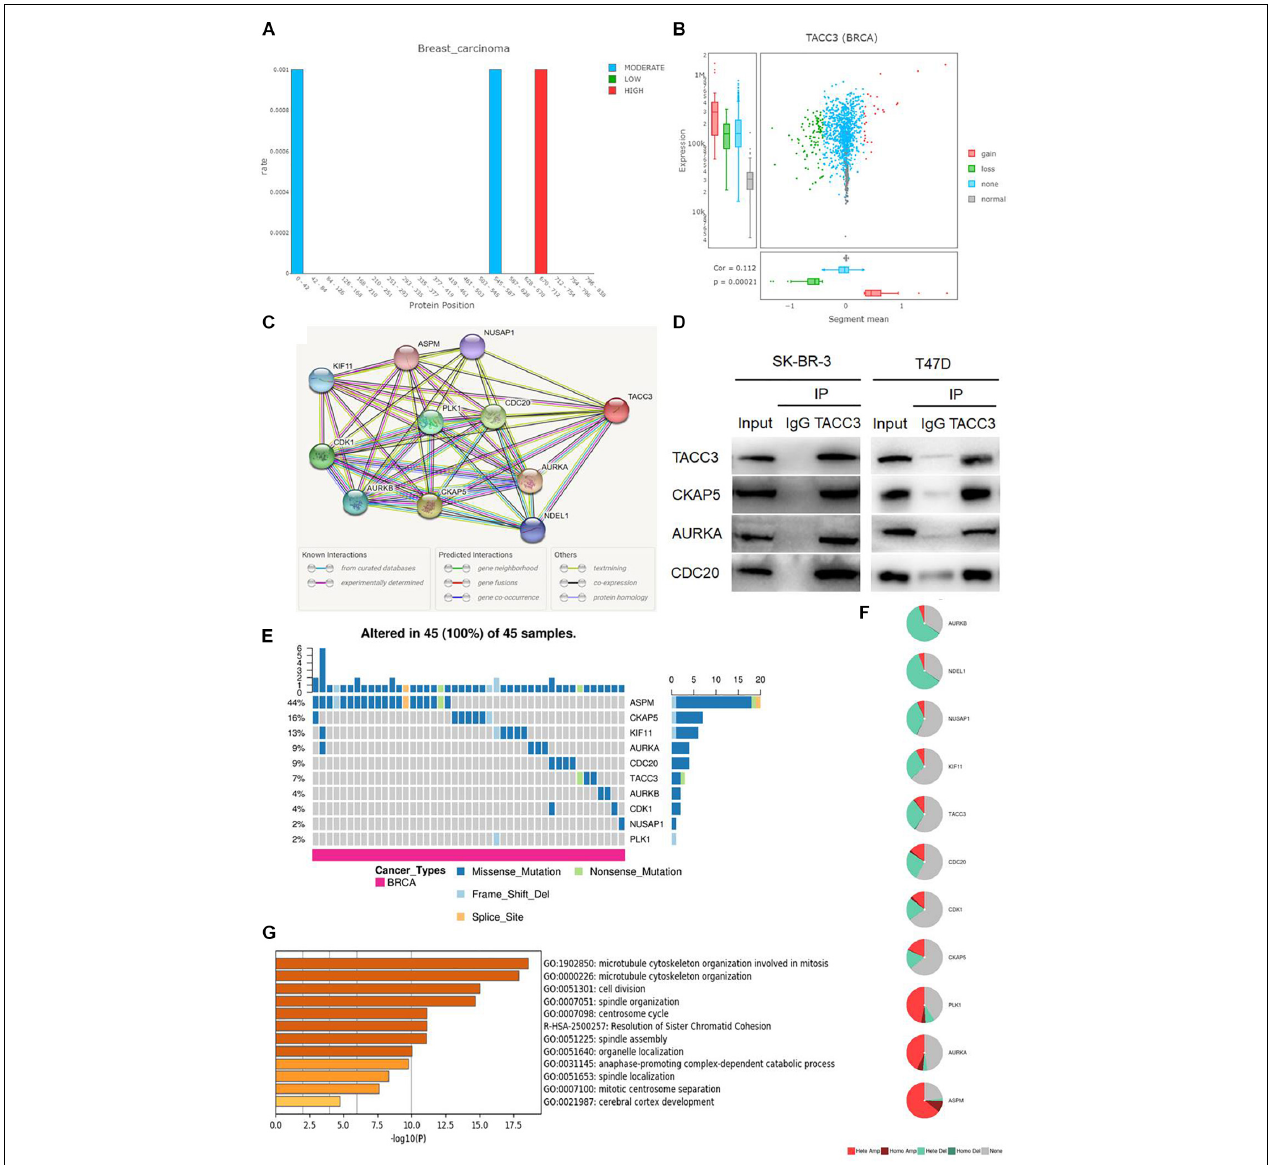
FIGURE 4 | Analysis of the mutation rate, CNVs distribution, and functional enrichment analyses of TACC3 in breast cancer. (A) the mutation rate of TACC3 and its protein positions in breast cancer. The mutation squares indicate the number of mutation tools that identify this gene as a mutation driver. (B) The CNV squares indicated CNV gain or loss of TACC3 in breast cancer. The red represents a gain (1) and the green represents a loss (–1). (C) The PPI network of TACC3 was constructed using the STRING database, and the network of TACC3 and its co-expression genes were set up visually. (D) Immunoprecipitation of anti TACC3 antibodies with CKAP5, AURKA, and CDC20 in cells. (E,F) Single-nucleotide variation (SNV) and copy number variation (CNV) analysis by GSCALite. (G) Metascape enrichment analysis results on the interacting genes that interacted with